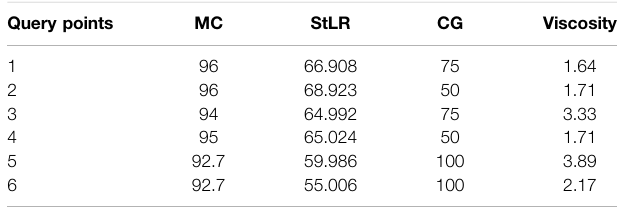
TABLE 3 | Case studies of randomly selecting query points to analyze parameter effects. Query points